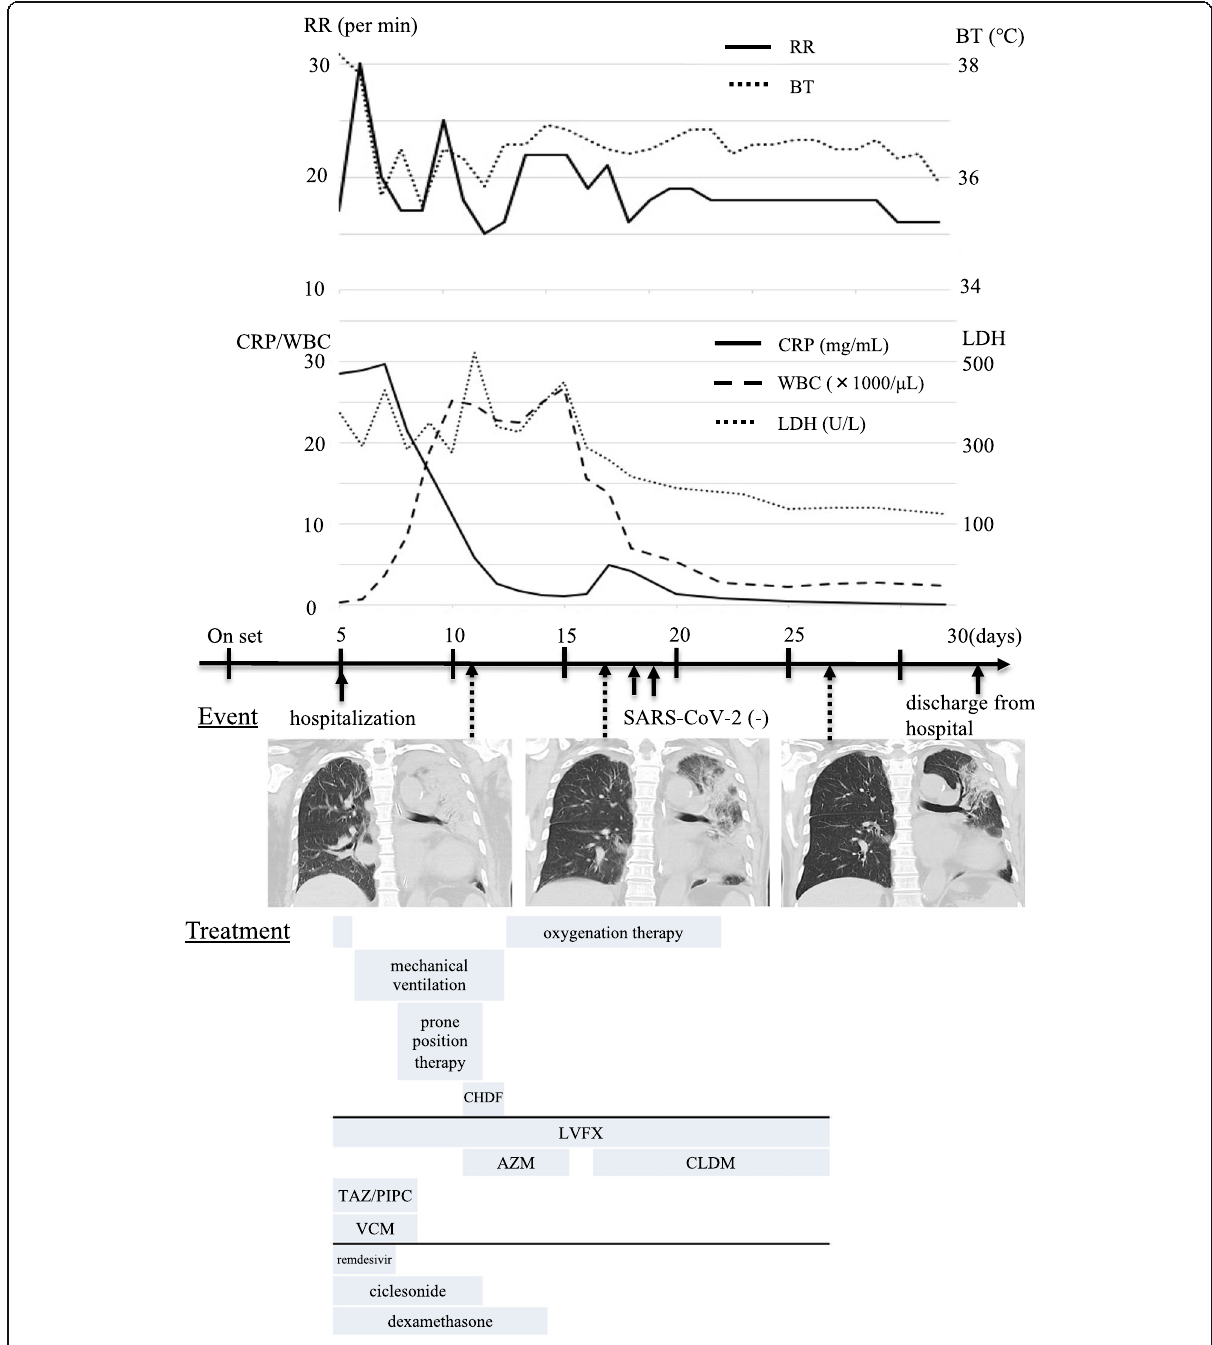
Fig. 2 Clinical course and changes in laboratory and computed tomography (CT) findings and vital signs. A time series of the clinical course including relevant laboratory and CT findings and vital signs is shown. RR, respiratory rate; BT, blood temperature; CRP, C-reactive protein; WBC, white blood cell; LDH, lactate dehydrogenase; SARS-CoV-2: severe acute respiratory syndrome coronavirus-2; LVFX, levofloxacin; AZM, azithromycin; CLDM, clindamycin; CHDF, continuous hemodiafiltration; TAZ/PIPC, tazobactam/piperacillin; VCM,